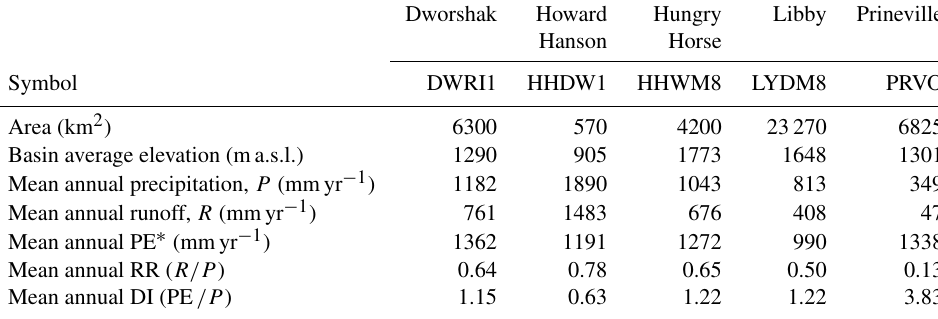
Table 1. List of basin characteristics. Hydrologic variables correspond to the period October 1980 to September 2015. P , R , PE, RR, and DI denote basin-averaged mean annual values of precipitation, runoff, potential evapotranspiration, runoff ratio, and dryness index, respectively.